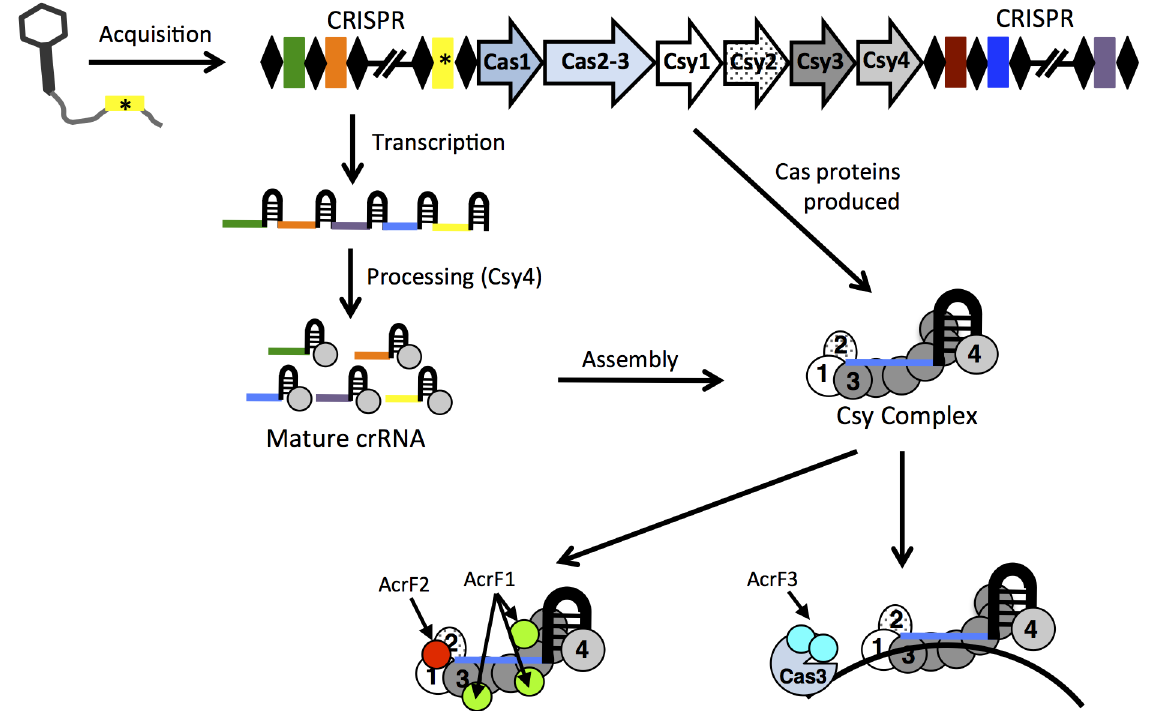
Fig 1. A model of the mechanisms of action of three anti-CRISPR proteins. The type I-F CRISPR loci consist of direct repeat sequences (black diamonds) separated by unique spacer sequences (colored rectangles) that were derived from foreign mobile genetic elements. During the acquisition stage, a piece of DNA from an invading phage or other mobile element is captured and inserted as a spacer into a CRISPR array (yellow rectangle). Next, the CRISPR-associated (Cas) proteins are produced, and the CRISPR loci are transcribed into long pre-CRISPR-RNAs. The Csy4 endonuclease then cleaves the repeat sequences to yield mature CRISPR-RNAs (crRNAs), each containing a single spacer sequence (colored lines). The crRNA-Csy4 complex then interacts with Csy1, Csy2, and Csy3 to form the surveillance complex. AcrF1 and AcrF2 directly interact with this complex and prevent DNA binding. By contrast, AcrF3 binds to the Cas3 helicase – nuclease protein and blocks its